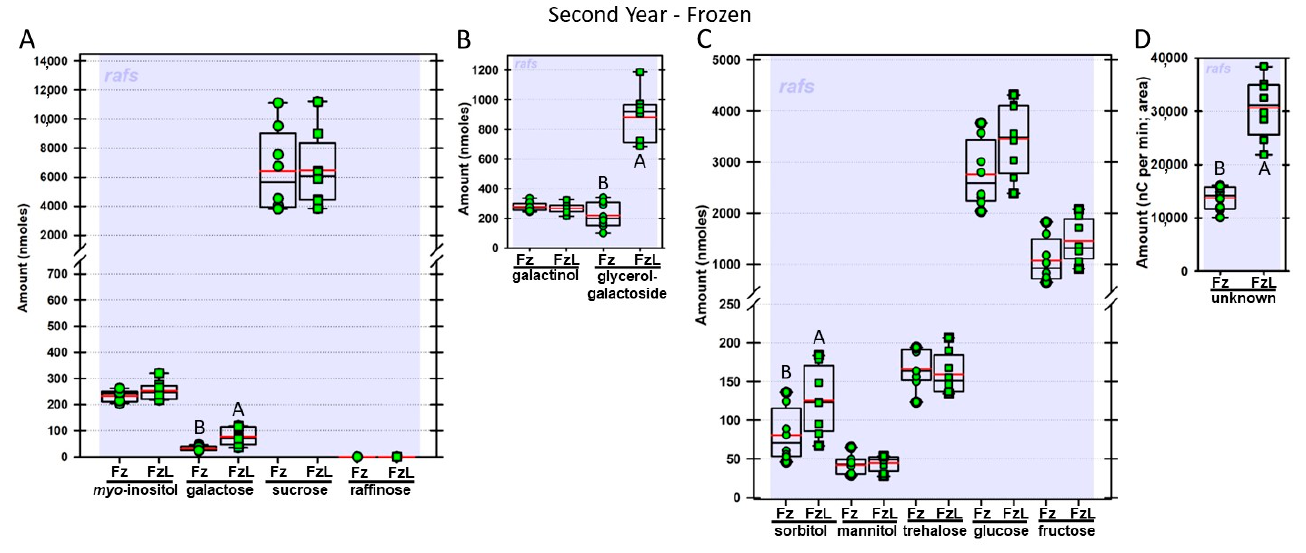
Figure 7. For a second year, carbohydrates were analyzed from raffinose synthase ( rafs ) maize leaves. The disks were frozen after harvest (Fz; light green circles) or were frozen and then lyophilized to dryness (FzL = frozen lyophilized; light green squares). The same carbohydrates are depicted, and statistically significant differences are determined in the same manner as in Figure 4.